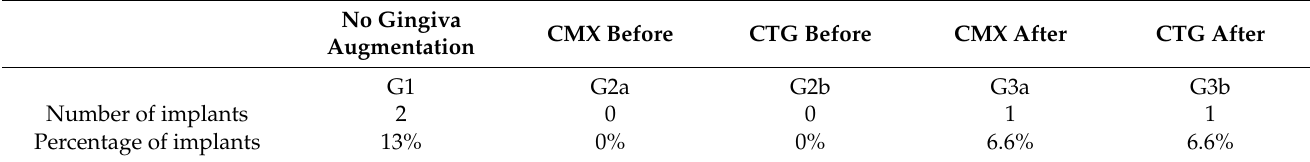
Table 5. Number of implants affected with peri-implantitis in each group.